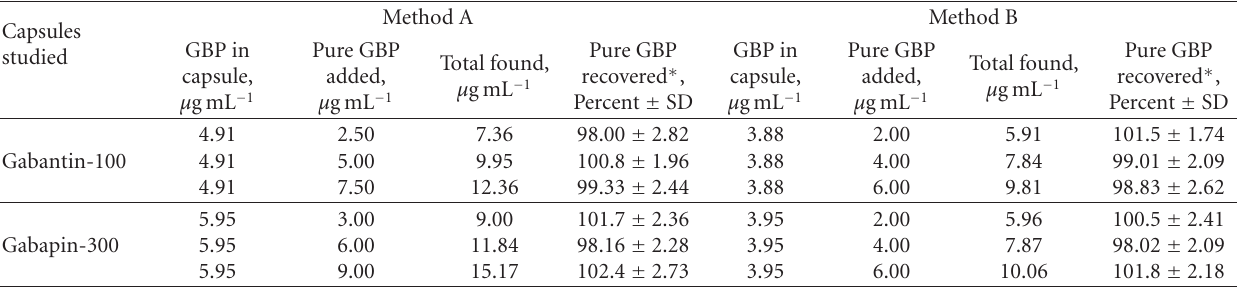
Table 7: Results of recovery study by standard addition method.